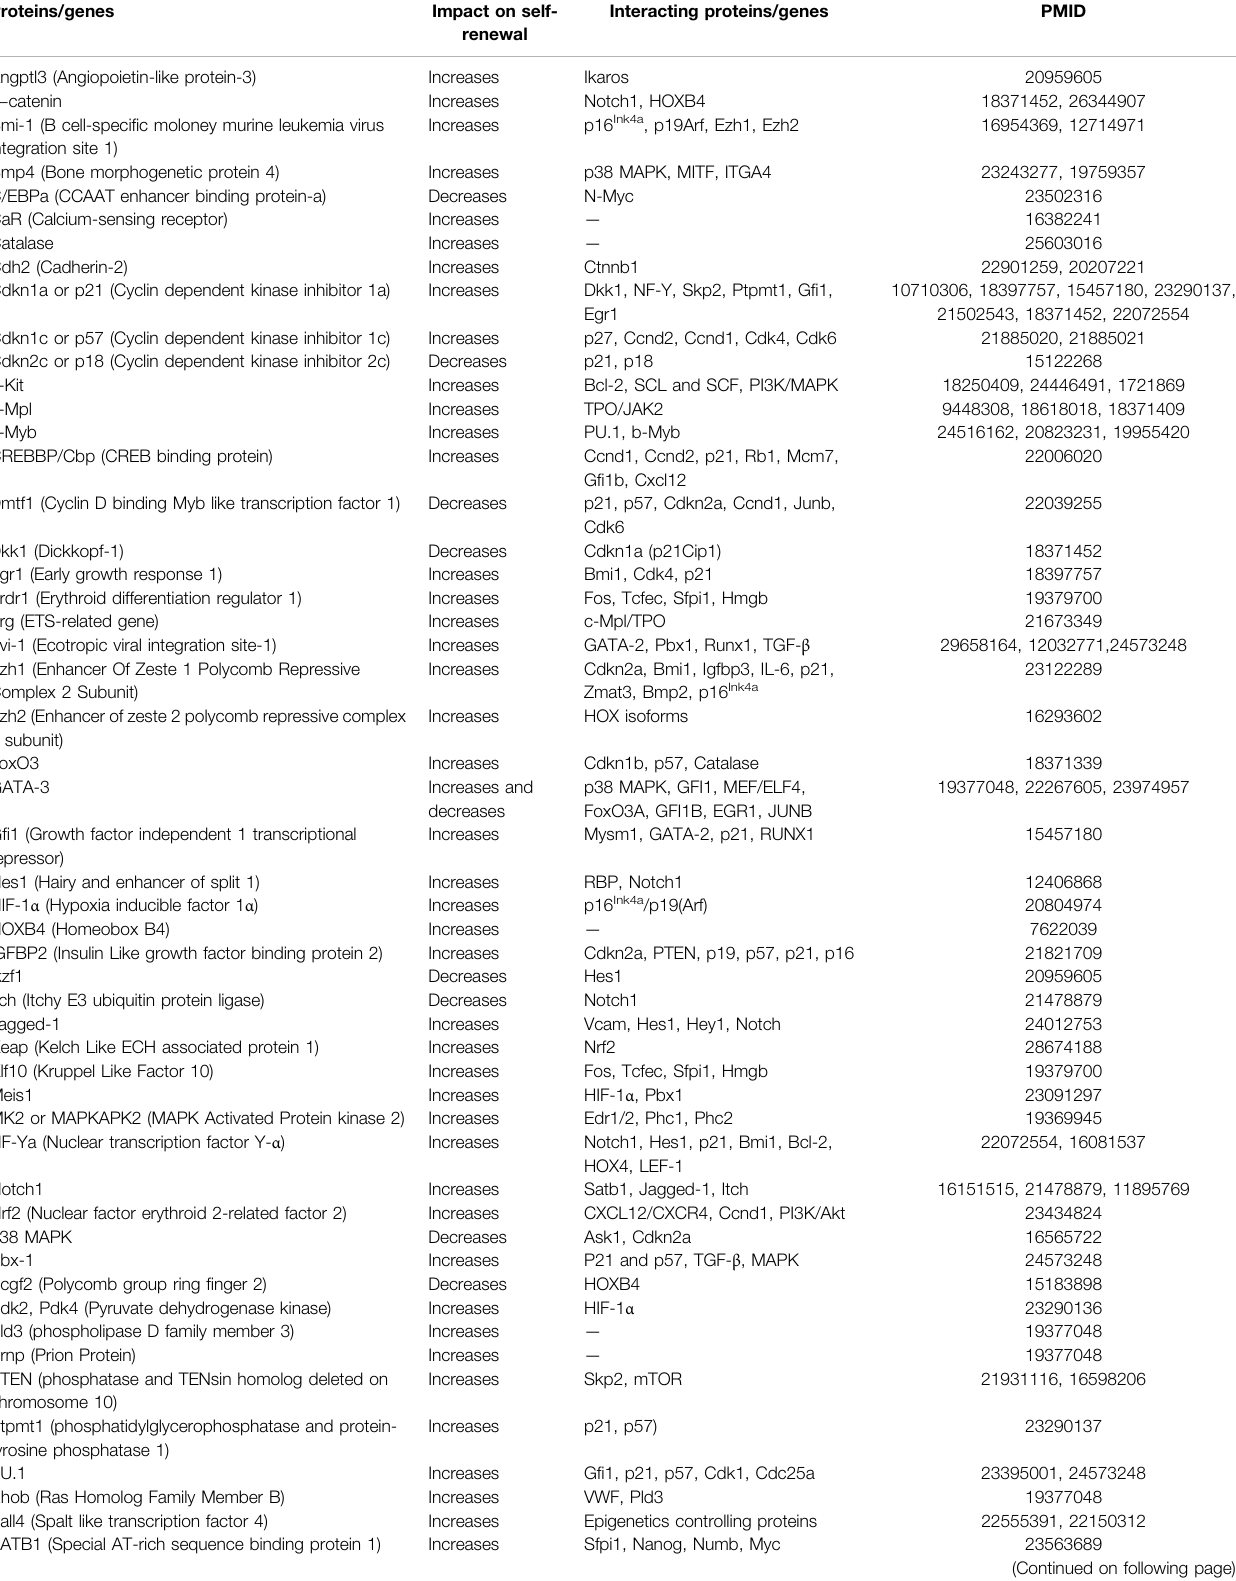
TABLE 1 | Proteins/genes, their impact on self-renewal, and their interaction with other proteins/genes involved in regulating